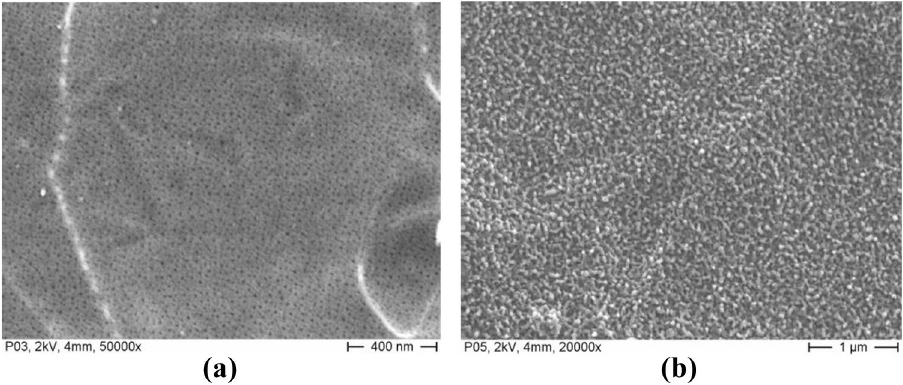
Figure 1. Anodic Oxidising: ( a ) Aluminium oxide Al 2 O 3 , ( b ) Boehmite